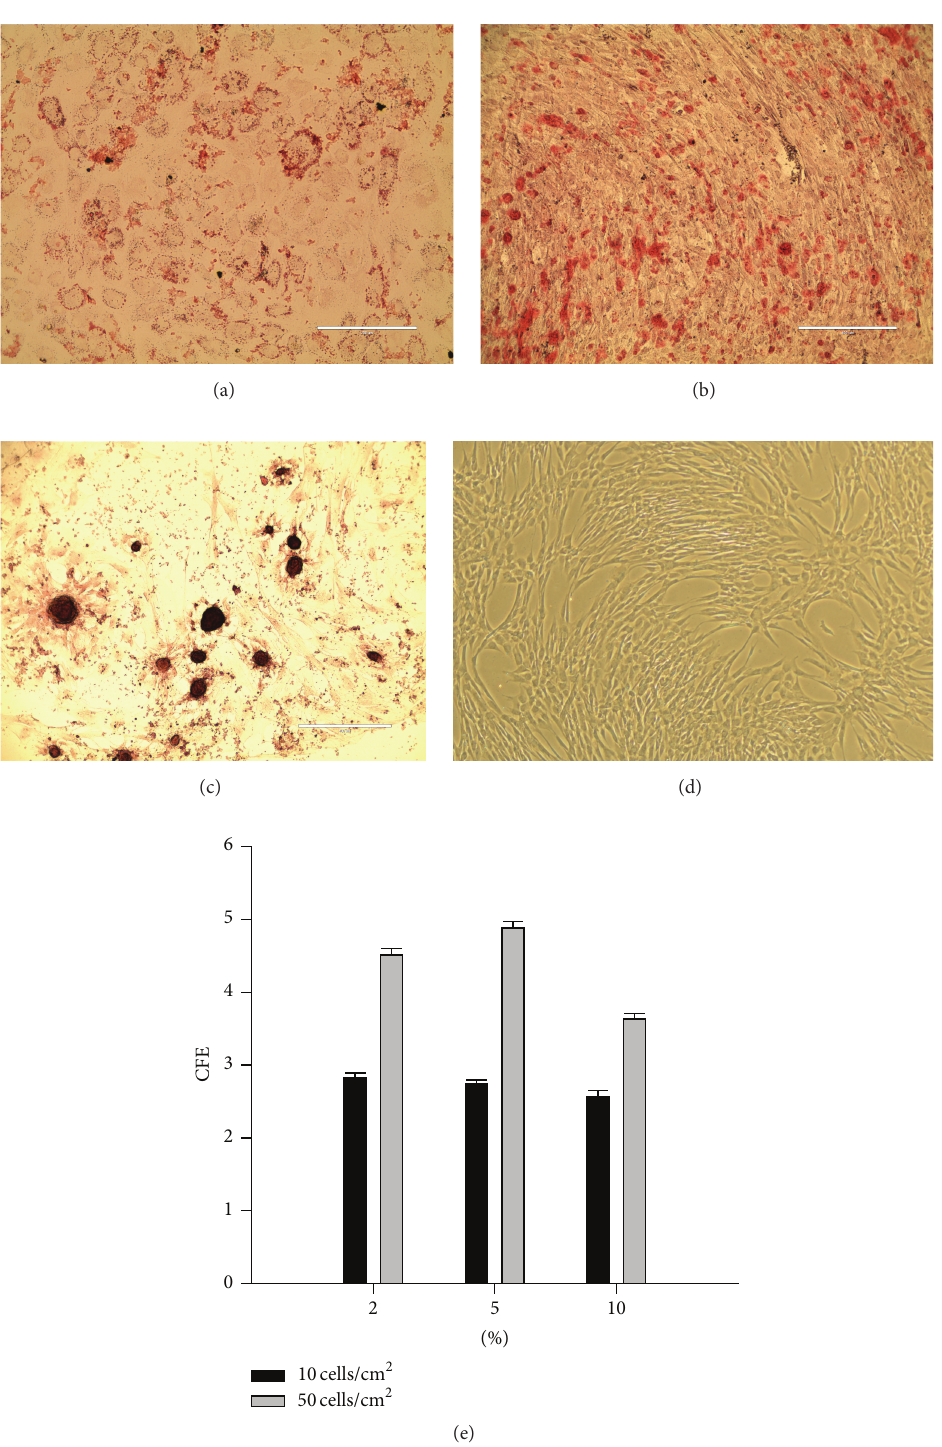
Figure 4: Differentiation and colony forming unit fibroblast (CFU-F) results for the characterization of UC-MSCs. (a) After adipogenic differentiation, MSCs were stained with Oil Red which binds to lipid droplets (20x objective magnification; scale bar = 200 micrometers). (b) After osteogenic differentiation, MSCs were stained with Alizarin Red S which binds to calcium deposits. (c) After chondrogenic differentiation, MSCs stained with Safranin O which binds to glycosaminoglycans in cartilage ((b) and (c) at 10x objective magnification; scale bar = 400 micrometers). (d) UC-MSCs in normal growth conditions (control) phase contrast micrograph at 4x objective magnification. (e) CFU-F efficiency was calculated by dividing the number of plated cells by the number of CFU-F colonies observed. Panel (e) shows colony forming efficiency versus human pooled platelet lysate (HPL) concentration in medium (2, 5, or 10% HPL) after plating at 5 (black bars) or 10 (gray bars) cells per cm 2 and 4 days in